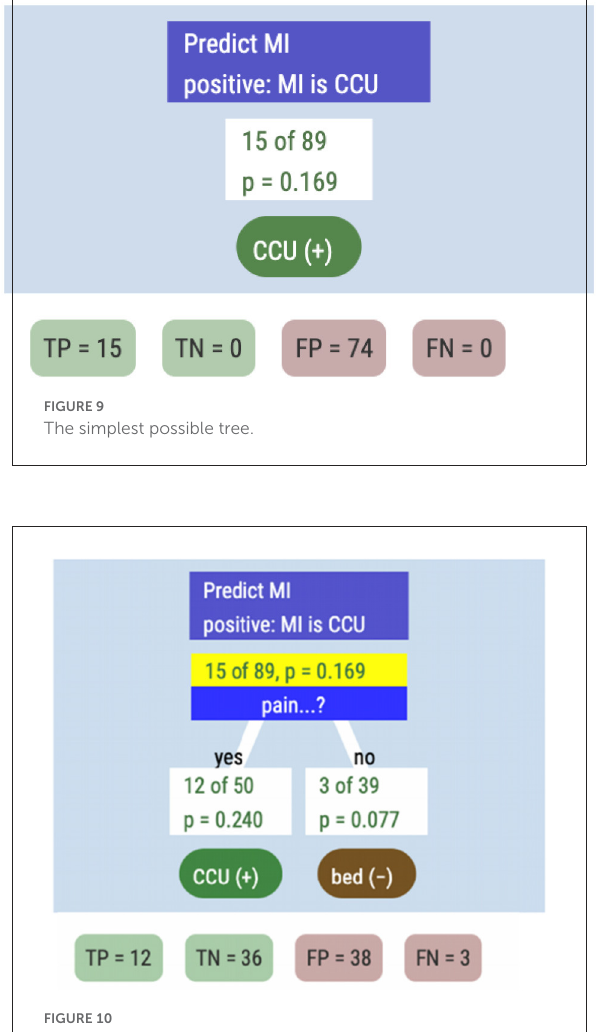
FIGURE10 A tree representing the criterion MI and one feature for classification, namely